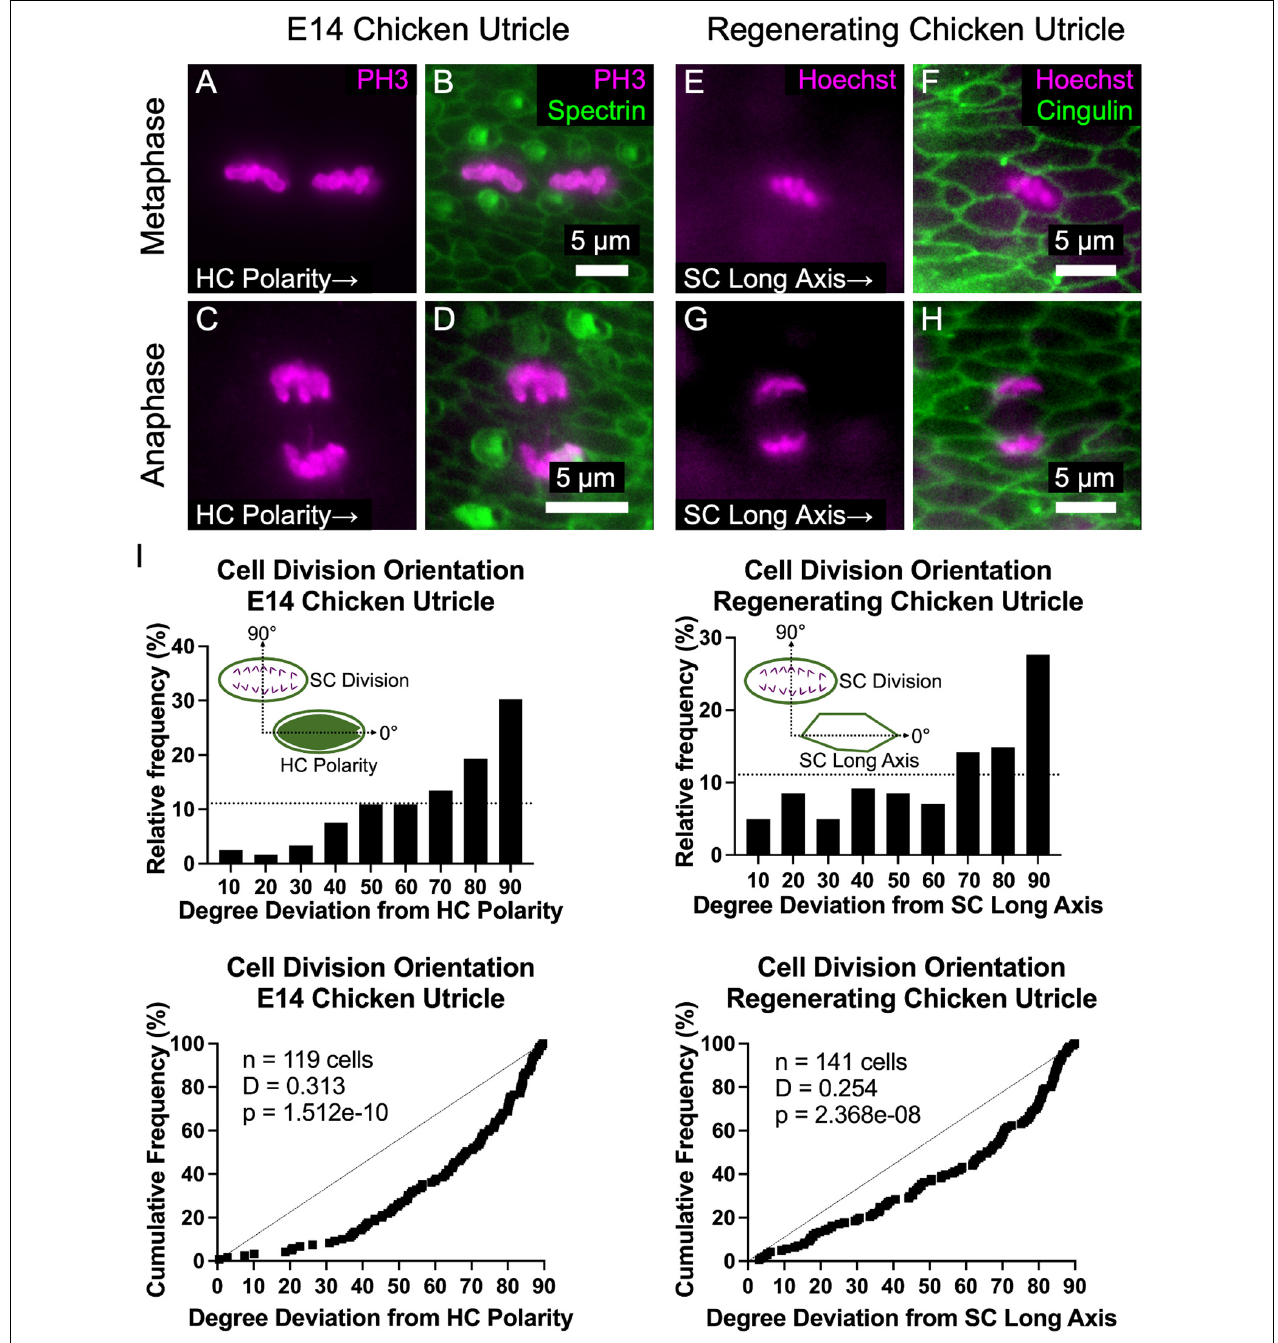
FIGURE 6 | The majority of supporting cell divisions in the developing and regenerating chicken utricle are oriented such that the division axis is perpendicular to the axes of HC polarity and SC elongation. (A–D) The orientation of PH3-labeled mitotic figures in metaphase (A,B) and anaphase (C,D) were measured with respect to the local axis of HC polarity, as visualized by spectrin immunostaining. (E–H) To determine whether regenerative cell divisions were oriented, utricles from P2 chickens were cultured in 1 mM streptomycin for 24 h to ablate HCs and fixed after a total of 72 h. Due to the high efficiency of HC killing with this approach, no HCs are present in the images. Images of cells in metaphase (E,F) and anaphase (G,H) were acquired with Hoechst labeling of cell nuclei, and the orientation of mitotic figures was measured with respect to the local axis of SC elongation, as visualized by cingulin immunostaining. (I) Top: Histograms of cell division orientation during development and regeneration. The bins have a width of 10 degrees and the x -axis labels denote the upper boundary of each bin. The dashed lines denote a uniform distribution (i.e., randomly oriented divisions). Bottom: Cumulative distribution functions of cell division orientation during development and regeneration. Dashed lines denote randomly oriented cell divisions. KS tests revealed that the measured cell division orientations were significantly non-random during development ( p = 1.512e-10, D = 0.313, n = 119 cells) and regeneration ( p = 2.368e-8, D = 0.254, n = 141 cells).